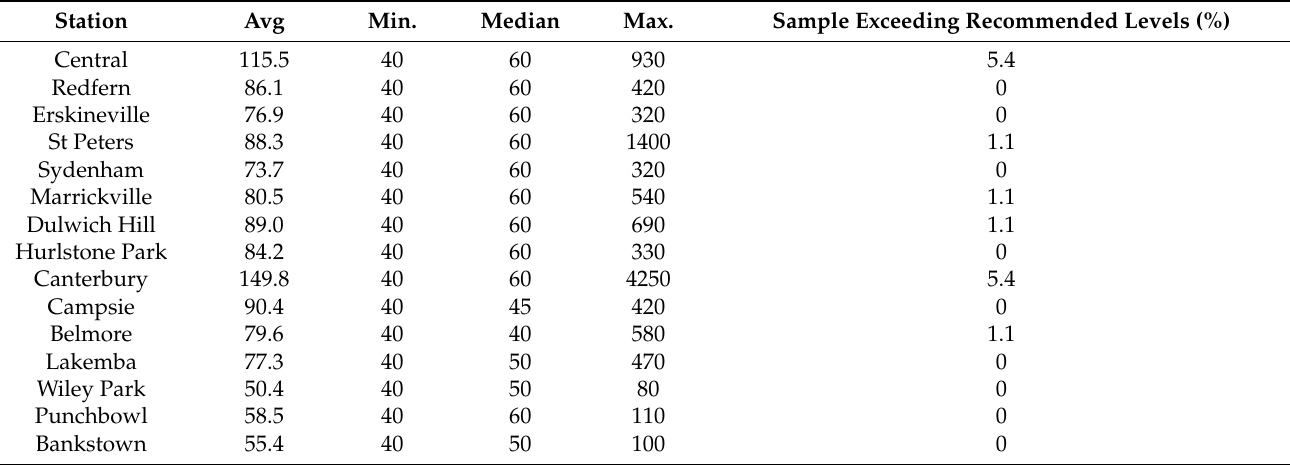
Table 5. Average concentrations of TVOC inside the train carriage over 3 months (from November 2021 to January 2022) for all stations of T3 line. Min.